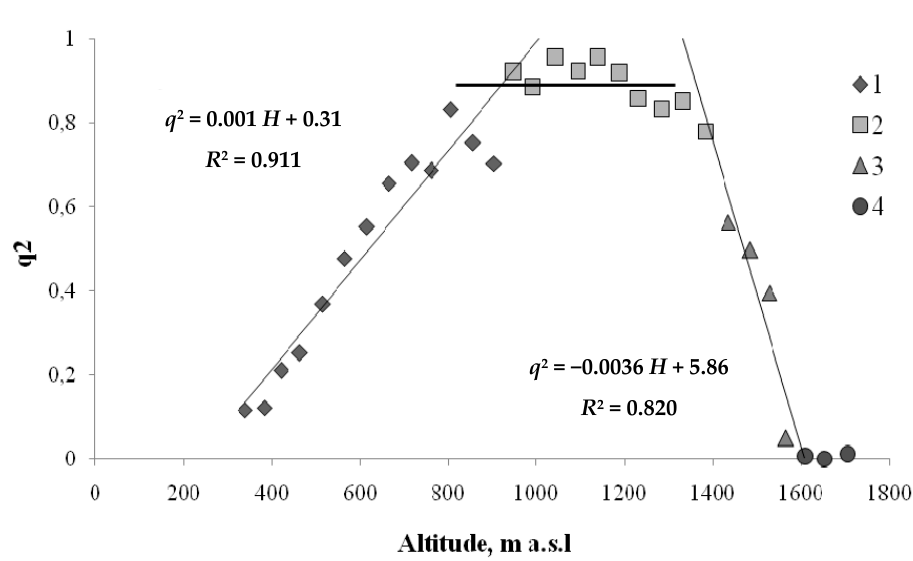
Figure 6. Order parameter versus height for the boundaries of coniferous tree habitats on the north-facing transect (1—hardwood–conifer ecotone; 2—the range of coniferous trees; 3—conifer–mountain meadow ecotone; 4—mountain meadow).